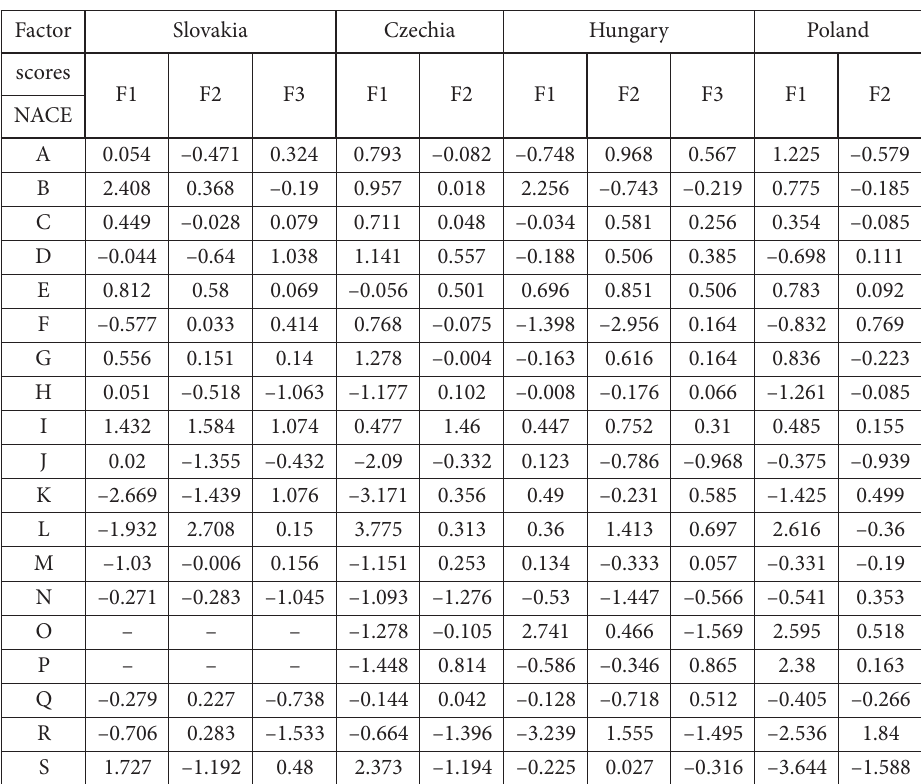
Table 2. Factor scores (source: authors) Factor